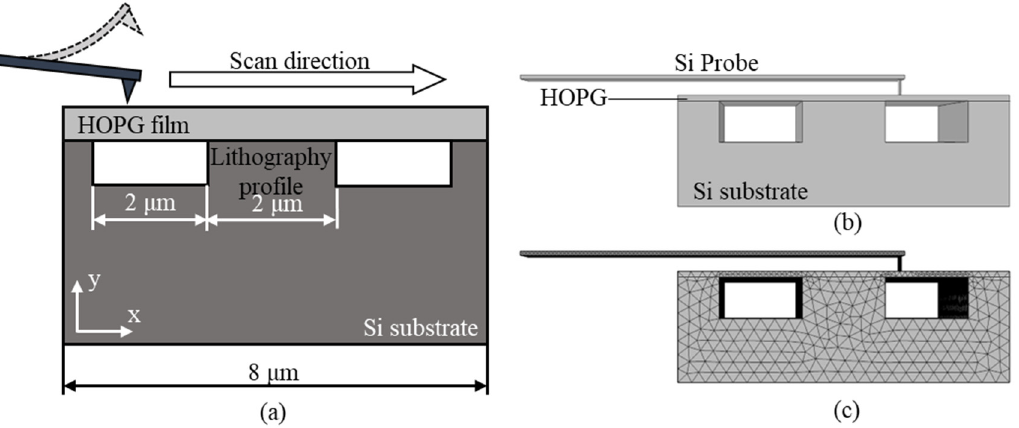
Figure 4. ( a ) Schematic of the simulation model. ( b ) shows the geometry model of finite element simulation and ( c ) shows the meshing for finite element simulation.